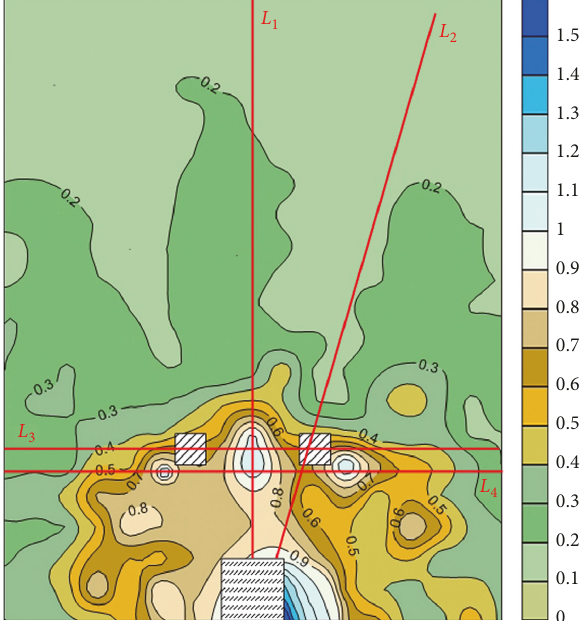
Figure 13: The contour map of ζ on